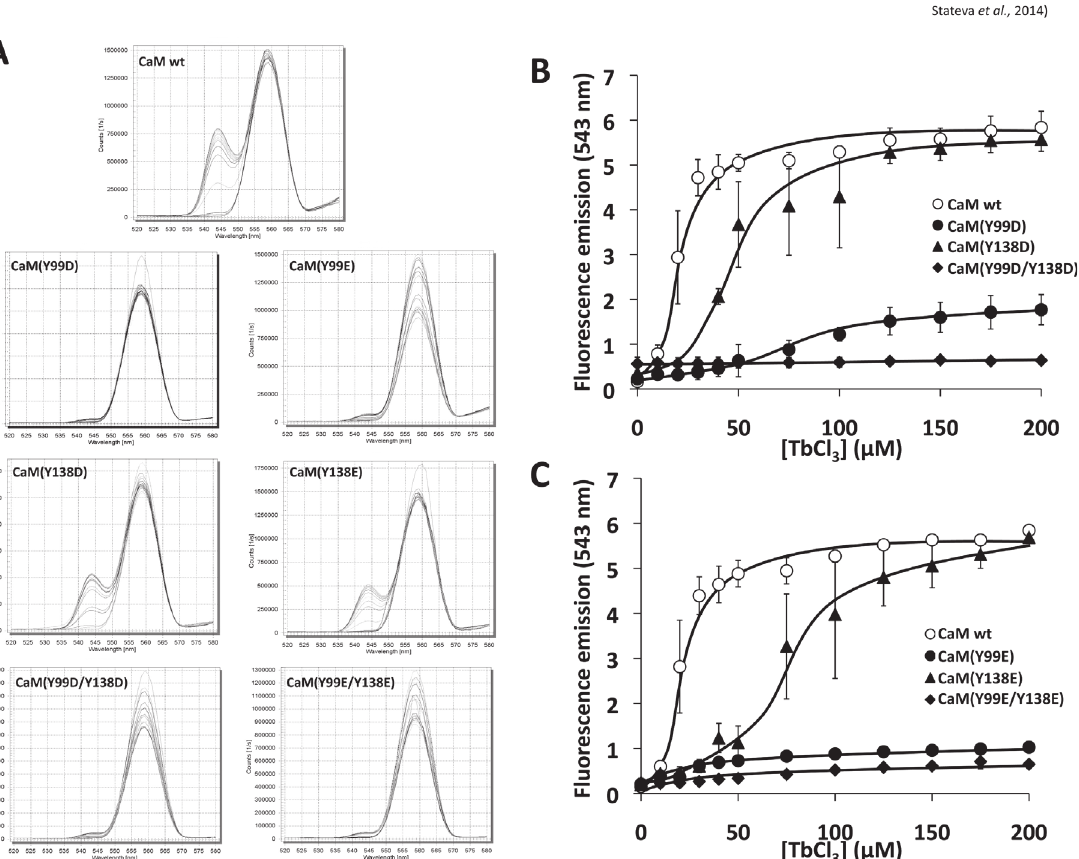
Fig 6. Tb 3+ -induced fluorescence emission spectra of the different CaM species. ( A ) The fluorescence emission spectra (520 – 580 nm) of wild type ( wt ) CaM and the indicated CaM mutants (10 μ M) was recorded in a buffer containing 10 mM Pipes-HCl (pH 6.5) and 100 mM KCl in the absence and presence of increasing concentrations of TbCl 3 (10 – 200 μ M) as described in Materials and Methods. ( B , C ) The plots present the emission fluorescence at 543 nm of wild type ( wt ) CaM and the indicated CaM mutants (10 μ M) at increasing concentrations of TbCl 3 in the conditions described in A